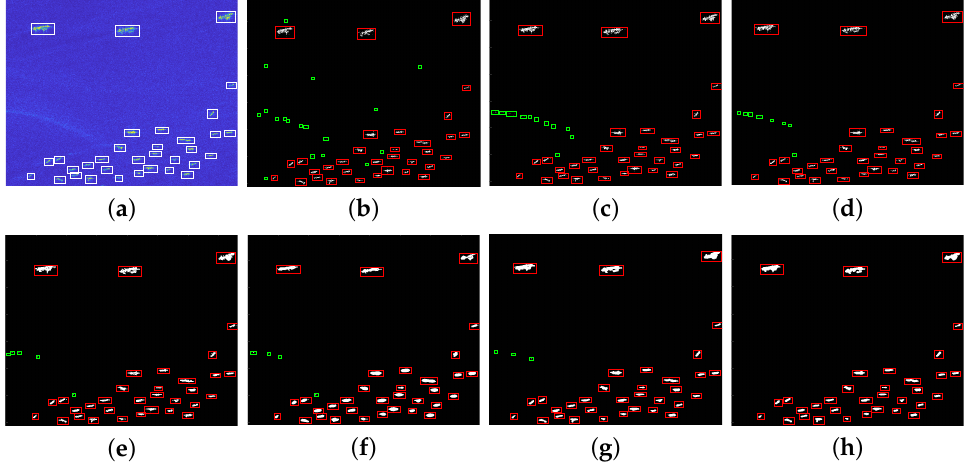
Figure 7. Detection results of different methods for scene 1. ( a ) original image; ( b ) CA-CFAR method; ( c ) G Γ D-CFAR method; ( d ) new LN-2PCFAR method; ( e ) MVWIE method; ( f ) FMPCM method; ( g ) IG method; ( h ) proposed